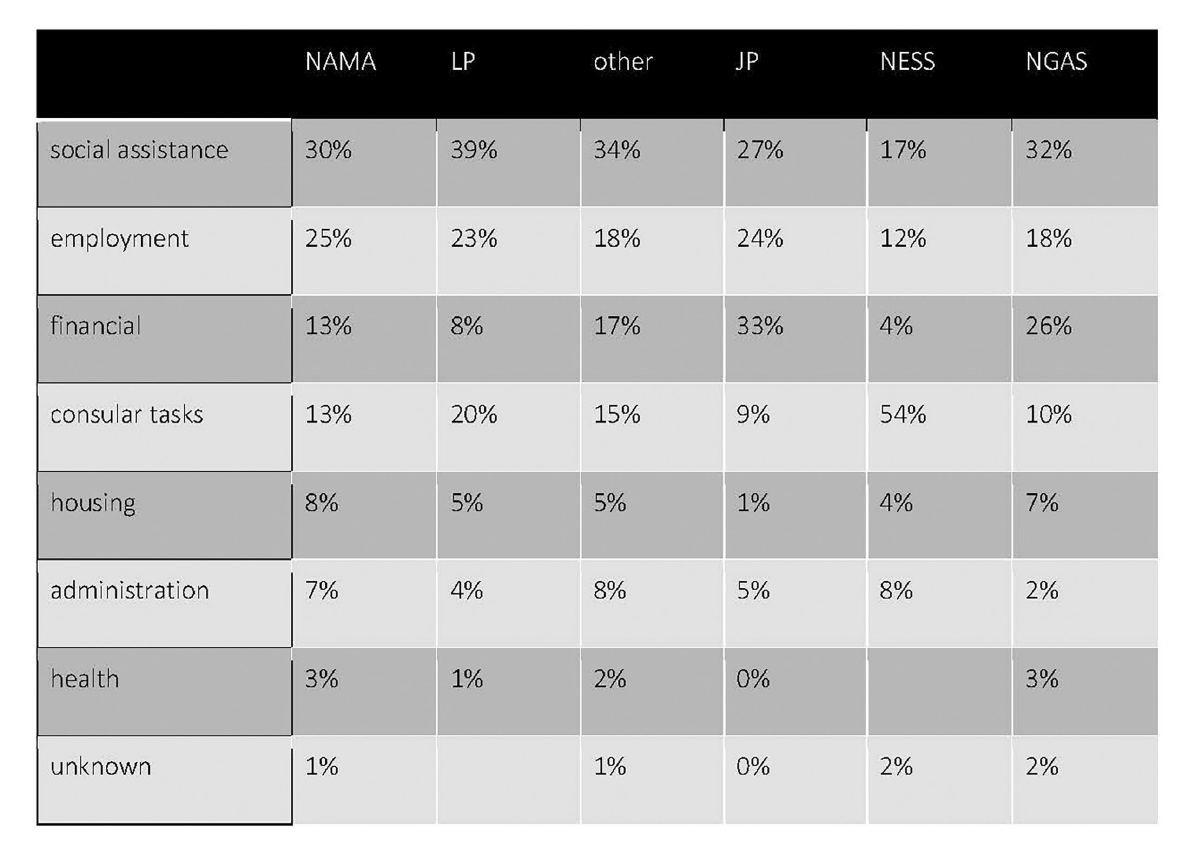
FIGURE9 Event-per-scheme in percent—(source—emigrant registration